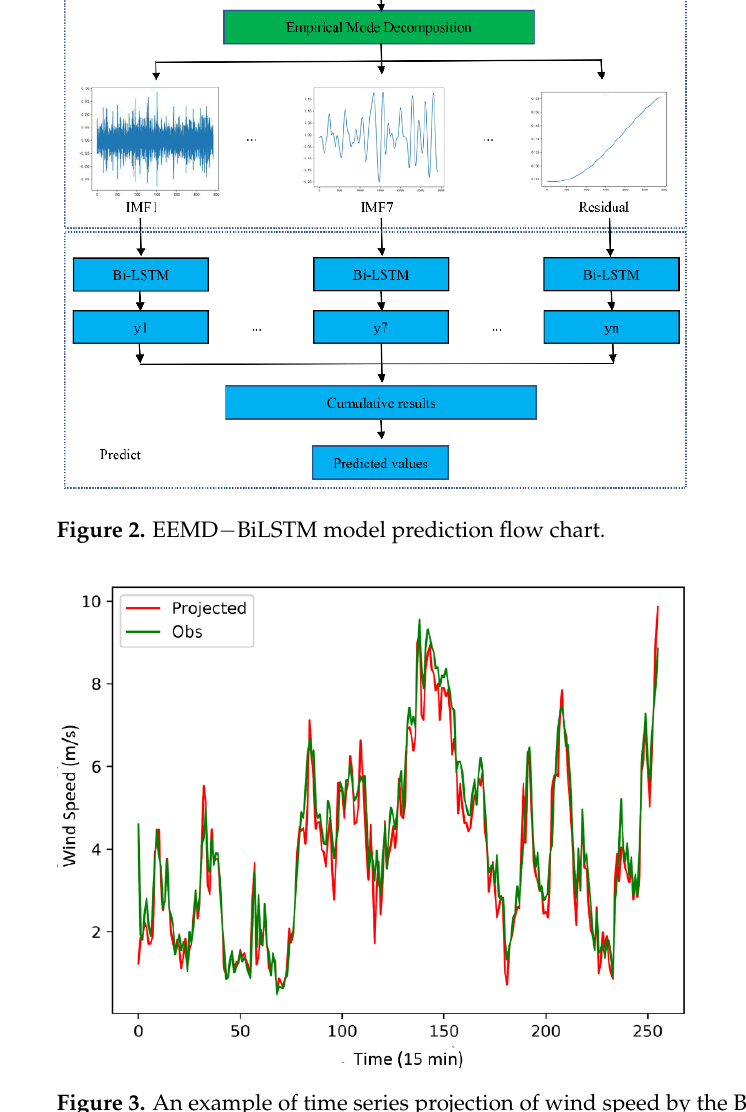
Figure 3. An example of time series projection of wind speed by the Bi ‐ LSTM model.